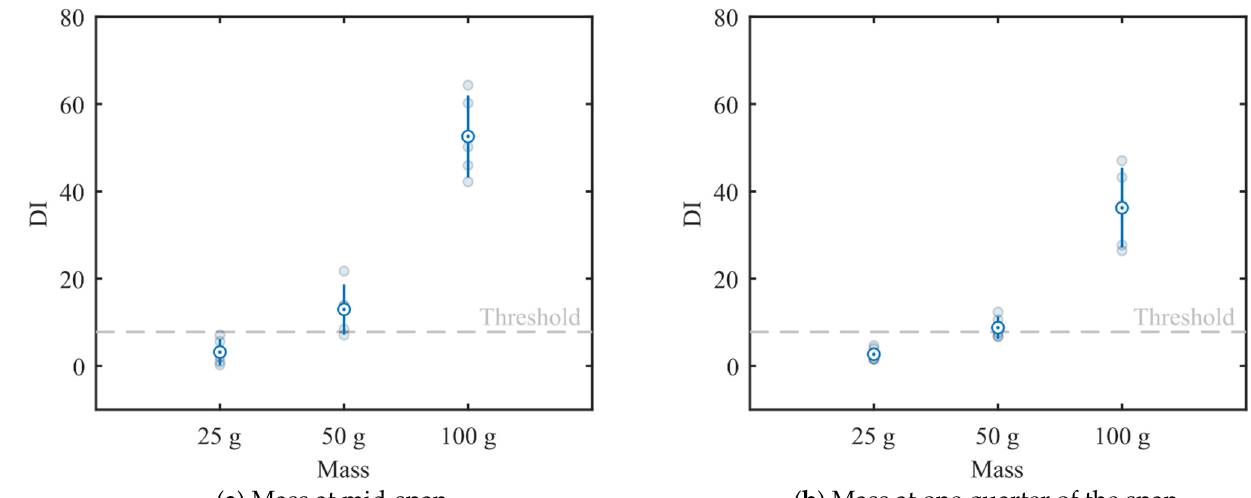
Figure 14. Damage index as a function of the added mass. Circular markers represent the five observations made for each added mass. The mean and standard deviation of each dataset are presented as the blue circle with a dot and the vertical blue bars, respectively.